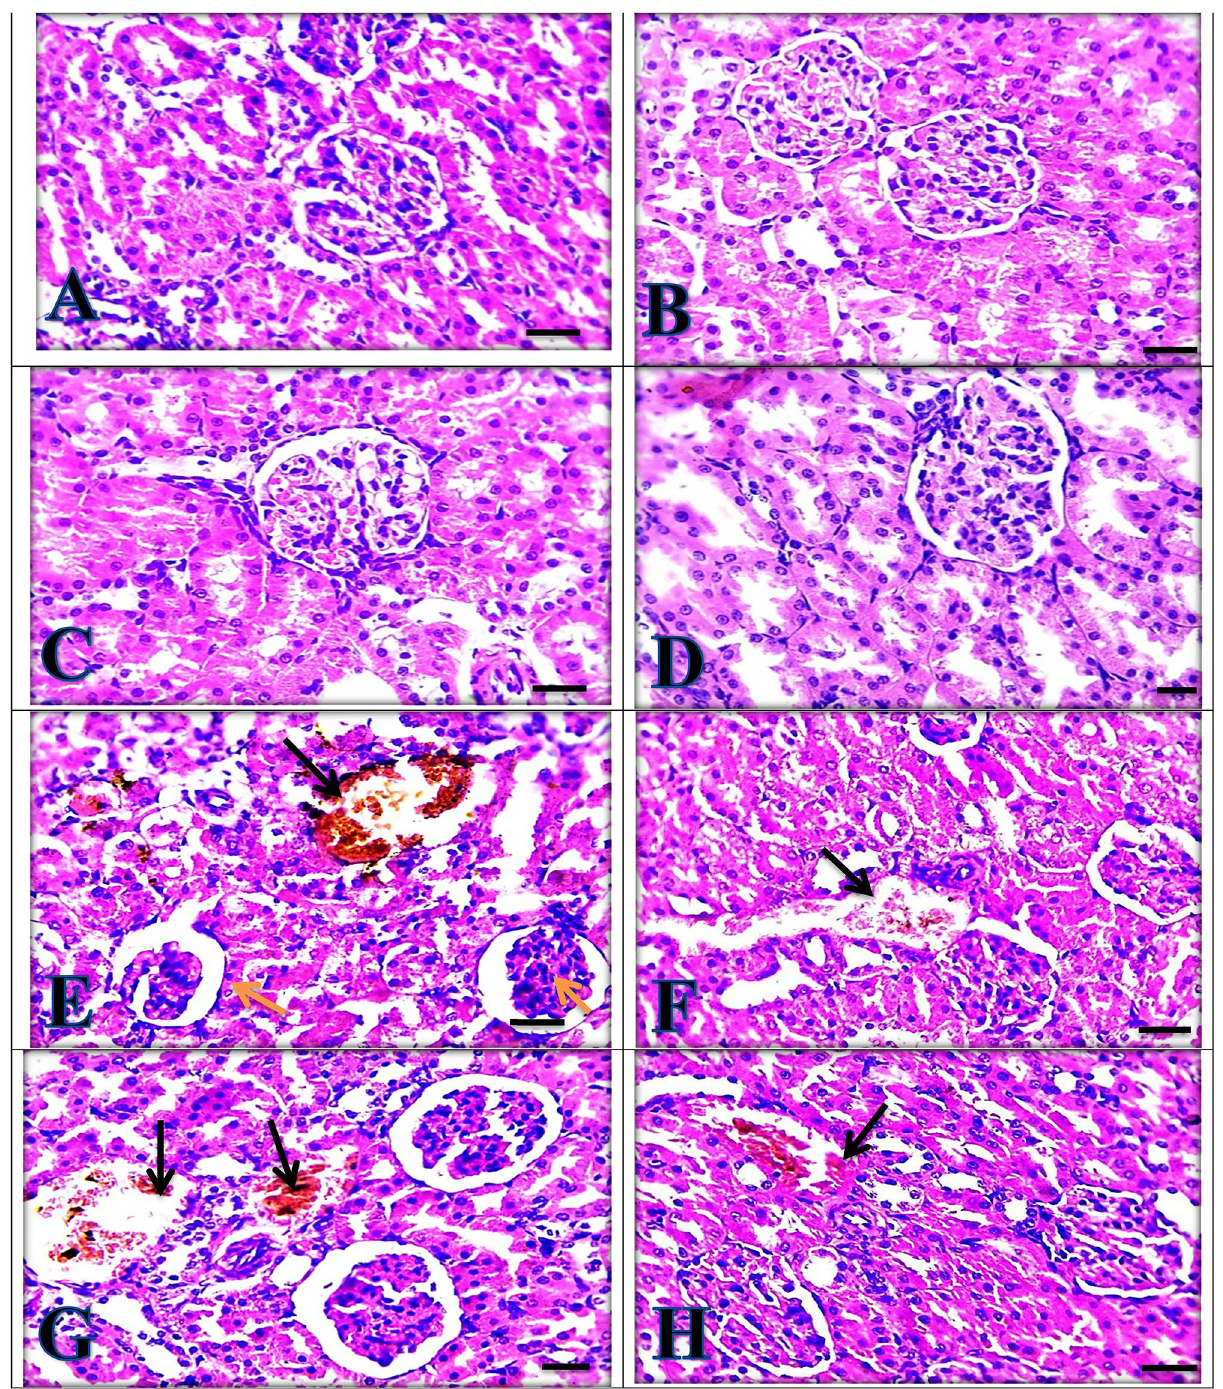
Figure 5. Kidney sections showing normal appearance in ( A ) control group, ( B ) Silymarin group, ( C ) Chlorella vulgaris group and ( D ) Chlorella vulgaris + Thiamine group. ( E ) Paracetamol group showing severe congestion (black arrow) and glomerular shrinkage (yellow arrows). ( F ) Silymarin + Paracetamol group and ( H ) Chlorella vulgaris + Thiamine + Paracetamol group showing mild congestion (black arrow). ( G ) Chlorella vulgaris + Paracetamol group showing moderate congestion (black arrow). ( H ) and ( E ) X: 400 bar